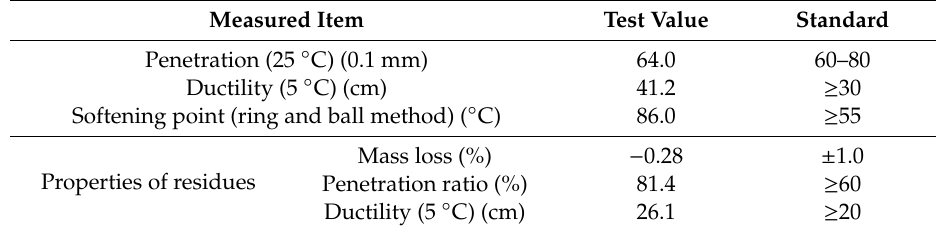
Technical properties of South Korea Ssangyong styrene–butadiene–styrene (SBS)-modified